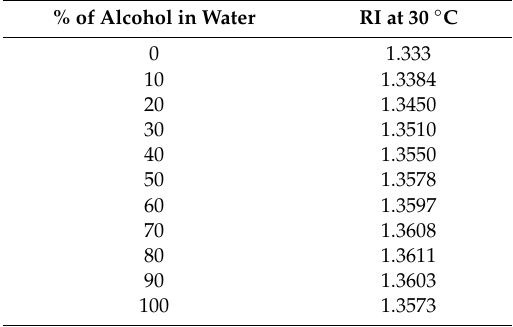
Table 1. Refractive index of various concentrations of alcohol in water